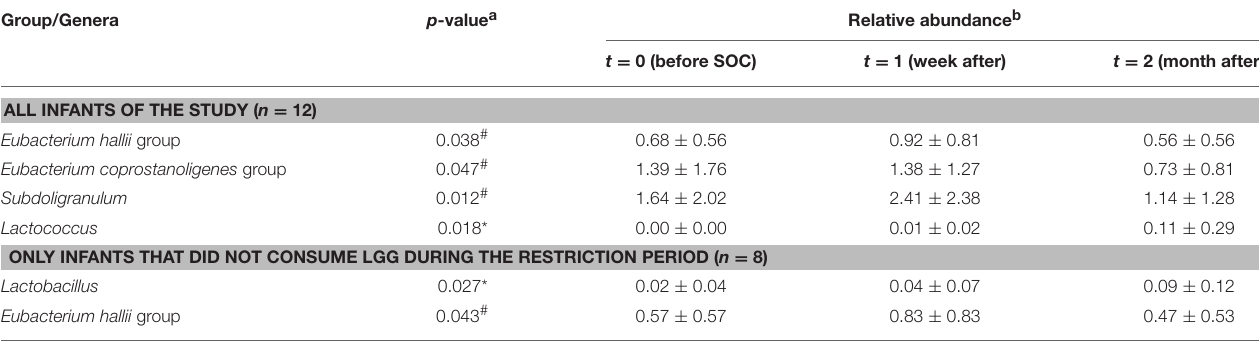
TABLE 1 | Significant differences in relative abundancies (%) of different bacterial groups in feces of infants outgrowing non-IgE CMPA, before and after ingestion of intact milk proteins with SOC and diet. Group/Genera p -value